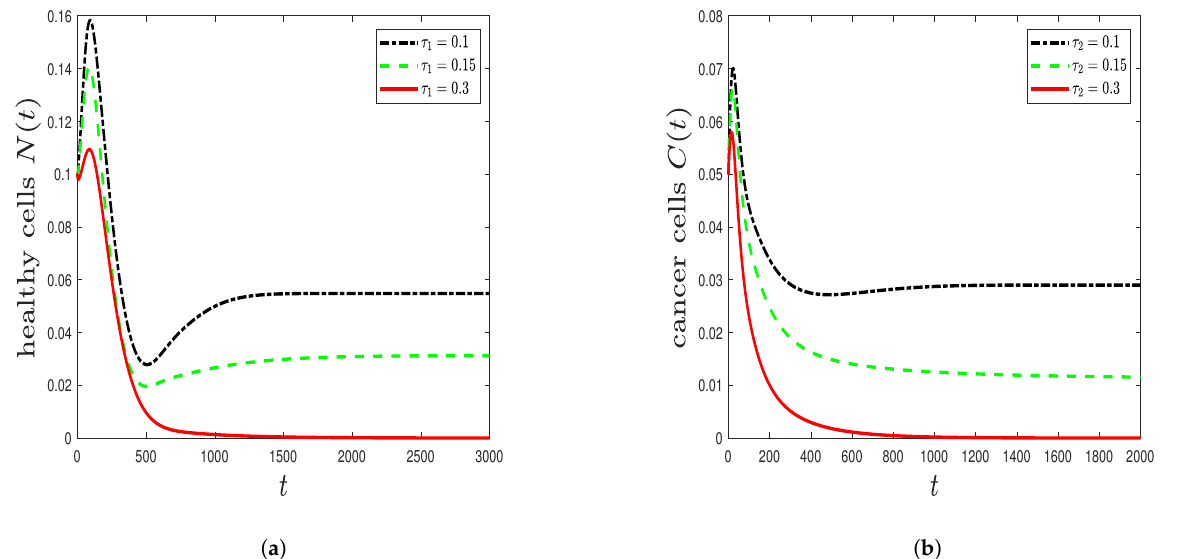
Figure 4. The effect of increasing time delays τ 1 and τ 2 on the concentration of ( a ) healthy epithelial cells N ( t ) and ( b ) cancer cells C ( t ) . The parameters are taken as ( a ) η 1 = 0.1, η 2 = 0.1, η 4 = 0.9, η 5 = 0.3, κ 1 = 0.01, κ 2 = 0.0005, κ 3 = 0.5, κ 4 = 0.0005, κ 5 = 0.07, and ( b ) η 1 = 0.3, η 2 = 0.2, η 4 = 0.03, η 5 = 0.3, κ 1 = 0.02, κ 2 = 0.02, κ 3 = 0.0005, κ 4 = 0.9, κ 5 =